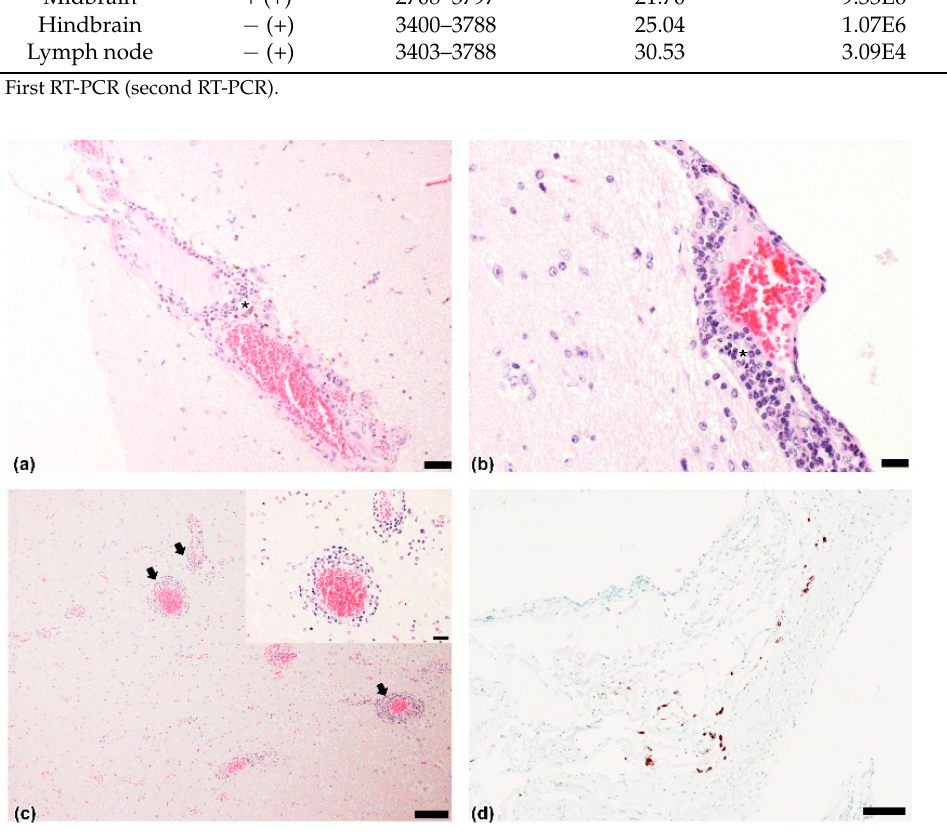
Figure 1. Histopathological findings and in situ hybridization (ISH) results: Cerebrum. Nonsuppurative meningoencephalitis with infiltration of mostly lymphocytes (asterisk) around blood vessels of meninges. Hematoxylin and eosin (H&E). Scale bar = ( a ) 50 μ m, ( b ) 20 μ m; ( c ) Nonsuppurative encephalitis with multifocal perivascular cuffing (black arrows) with lymphocytes. Brainstem. H&E. Scale bar = 100 μ m; insert magnification of perivascular focusing including 4–5 layers of mononuclear cells. H&E. Scale bar = 20 μ m; ( d ) Brownish ‐ black antigens observed after labeling of bovine astrovirus in meningeal lymphocytes. Brain. ISH. Scale bar = 100 μ m.